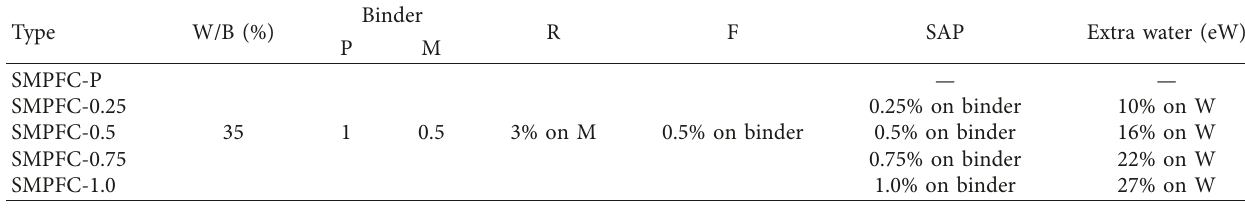
Table 2: Mix design.